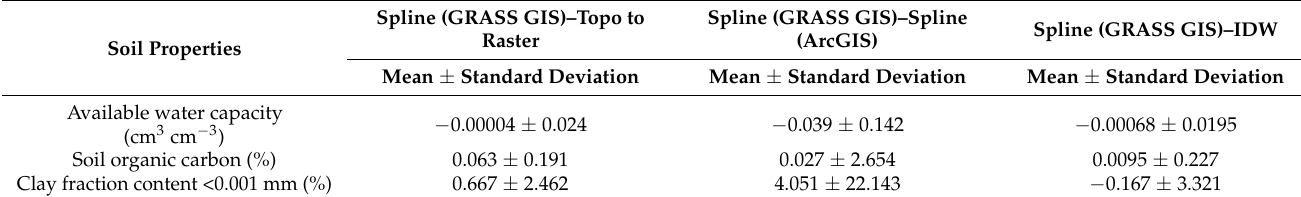
Figure 7. Comparison of GRASS GIS Spline with other interpolation methods for clay fraction content <0.001 mm: ( a ) Spline (GRASS GIS)—IDW (ArcGIS); ( b ) Spline (GRASS GIS)—Spline (ArcGIS); ( c ) Spline (GRASS GIS)—Topo to Raster (ArcGIS). Table 5. Comparison of interpolation methods by the differences in their values at the raster cell level. Spline (GRASS GIS)–Topo to Spline (GRASS GIS)–Spline Spline (GRASS Raster (ArcGIS) Soil Properties